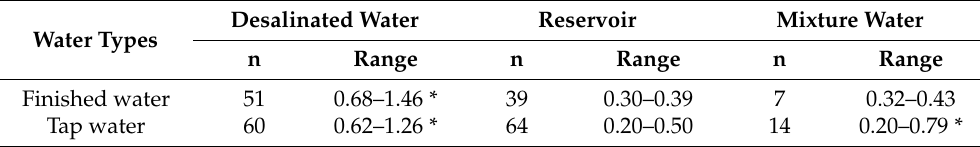
Table 1. Boron concentrations in different types of water